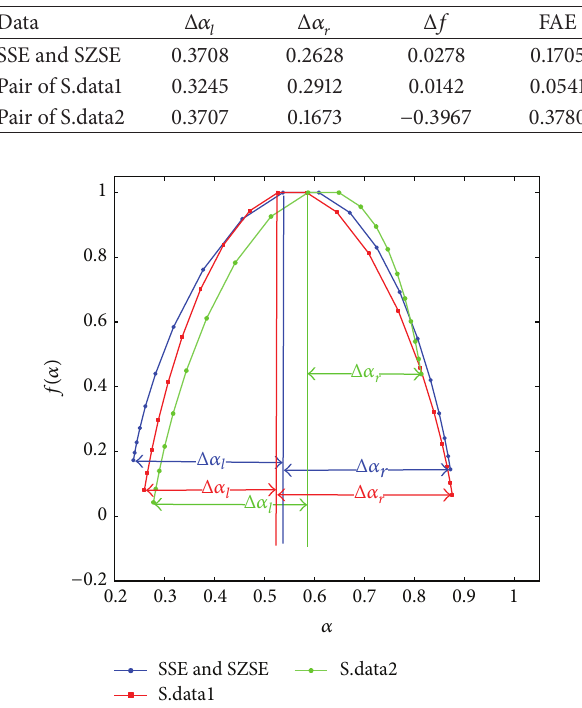
Figure 7: Multifractal spectra 𝑓(𝛼) of returns for the real data and the simulation